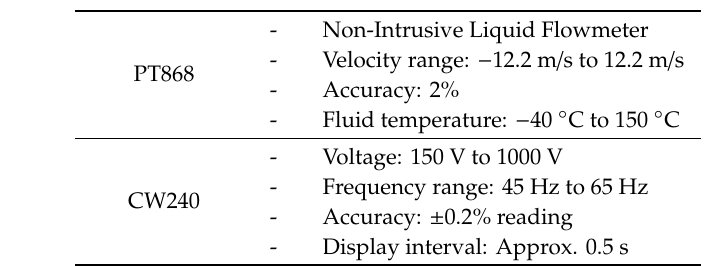
Table 2. Specifications of the